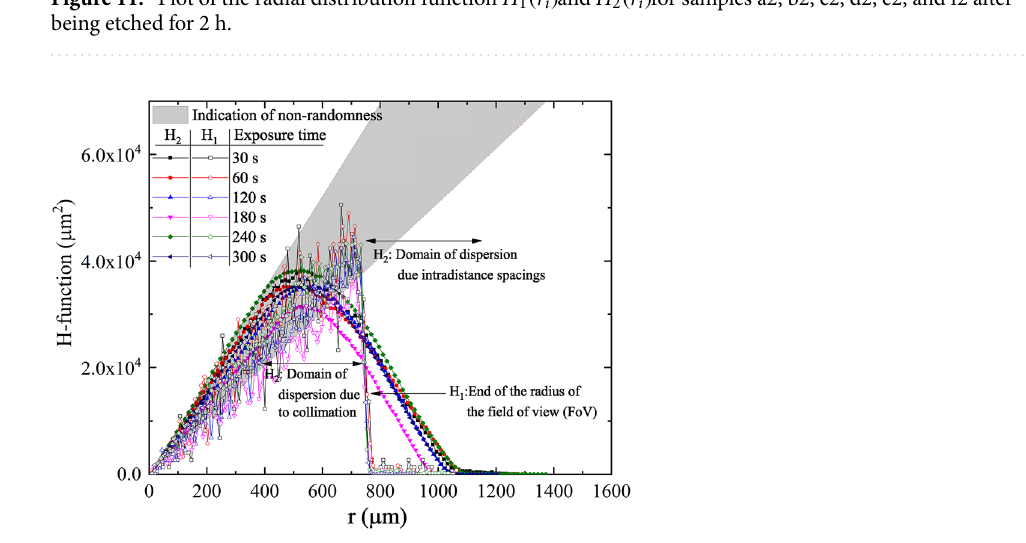
Figure 12. Plot of the radial distribution function H 1 ( r i ) and H 2 ( r i ) for samples a4, b4/1, c4, d4/1, e4, and f4 after being etched for 4 h.